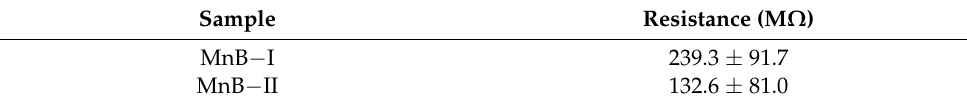
Table 2. The resistance of each sample/region as determined from C-AFM IV measurements ( n = 20).